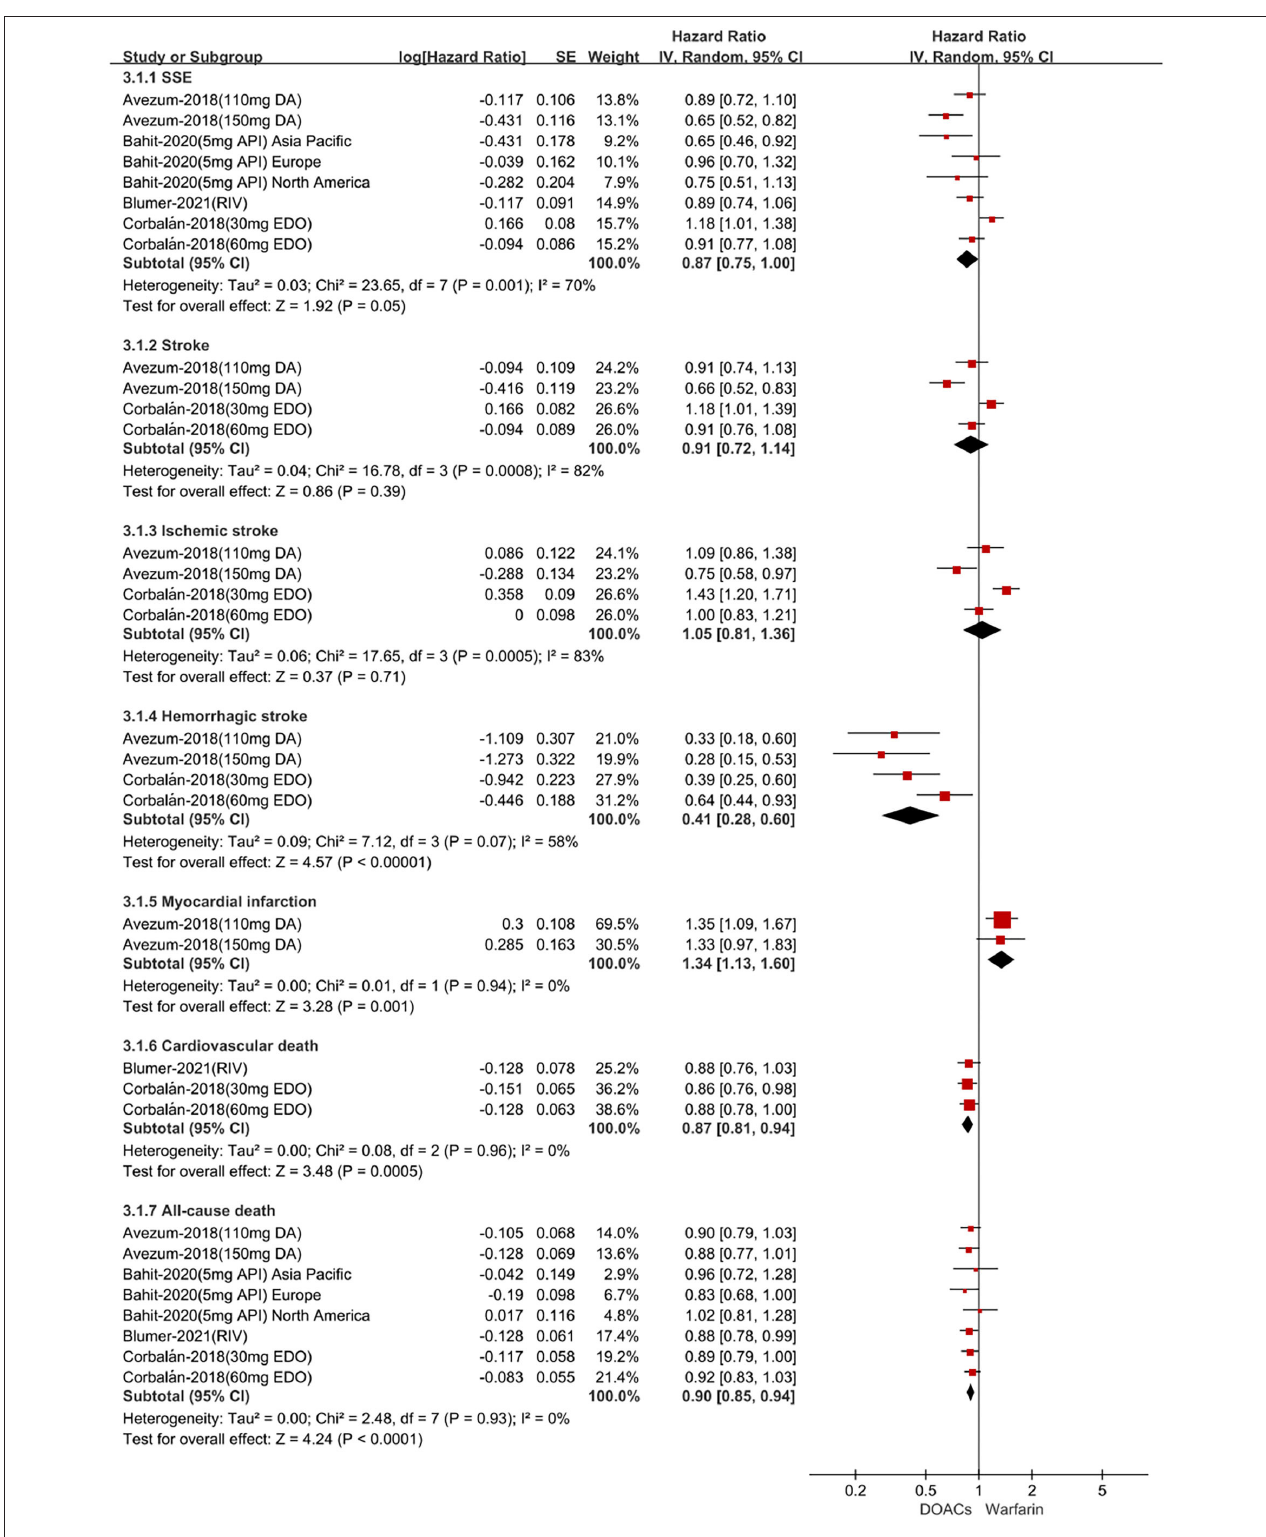
FIGURE 3 | Adjusted effectiveness date of direct oral anticoagulants compared with warfarin in non-Latin patients with atrial fibrillation. DOACs, direct oral anticoagulants; DA, dabigatran; API, apixaban; EDO, edoxaban; RIV, rivaroxaban; SSE, stroke or systemic embolism; CI, confidence interval.